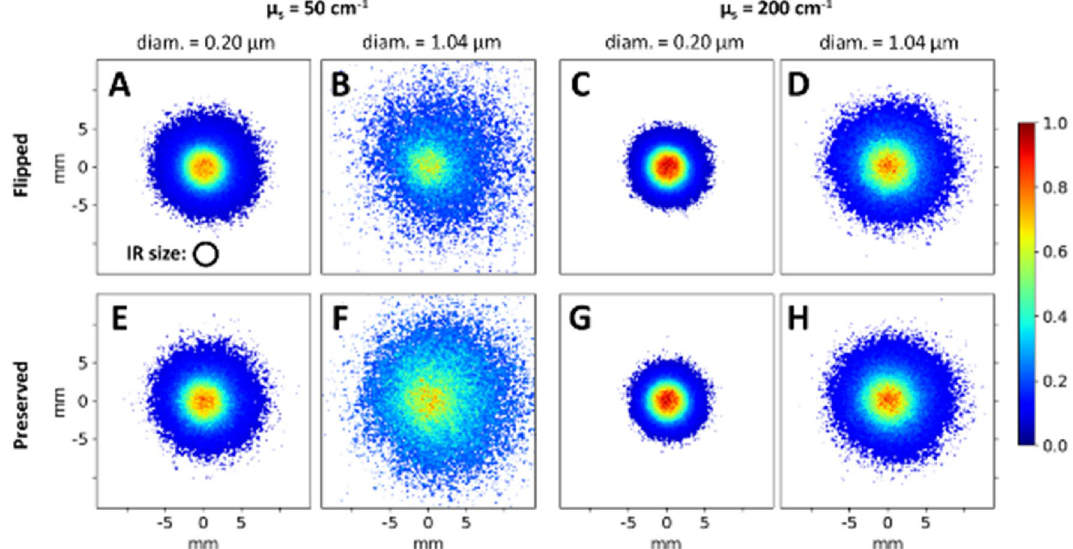
Figure 4. Helicity-flipped (top row) and helicity-preserved (bottom row) intensity images of backscattered circularly polarized light from four different monodispersed polystyrene suspensions, each having a sphere diameter of either 0.20 μm or 1.04 μm and scattering coefficient of either 50 cm −1 and 200 cm −1 (see labels). The drawn circle in A shows the size of the centrally illuminated region. It is visually apparent that the characteristics of resultant images are dependent on the scatterer size and turbidity (for discussion of noted trends, see